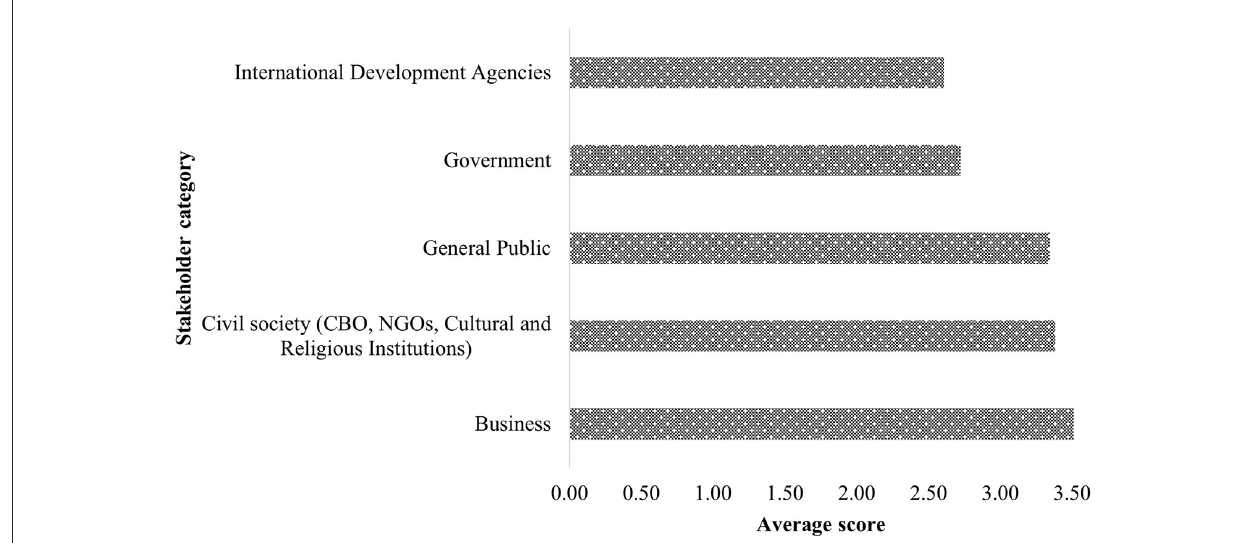
FIGURE9 Respondents’ perceptions on extent of CE initiatives implemented by stakeholder groups.